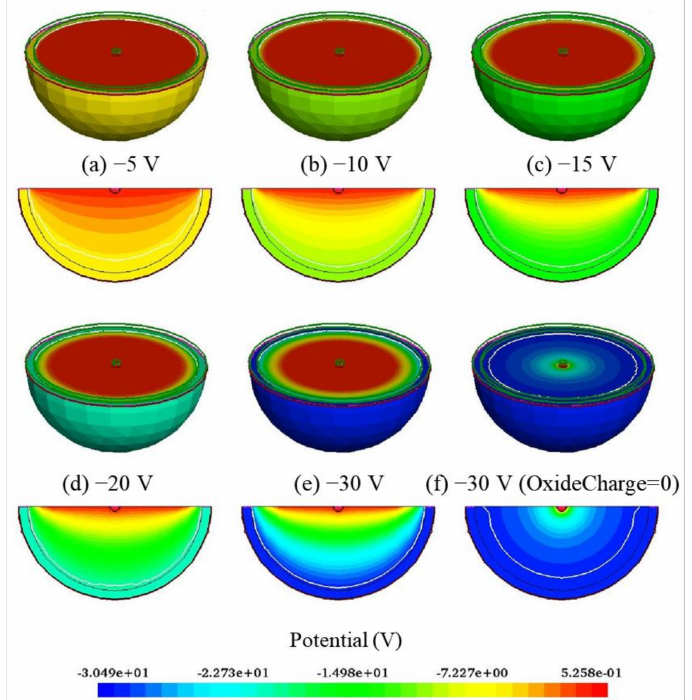
Figure 2. 3D and 2D electric potential distributions with different bias voltages.